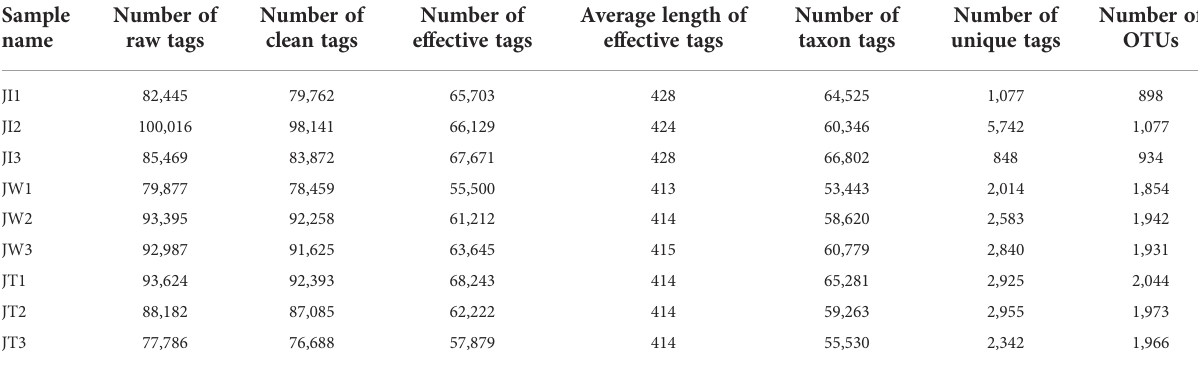
TABLE 2 16S rRNA gene sequencing results of 9 samples of shrimp intestine (JI), water (JW), and ef fl uent (JT).